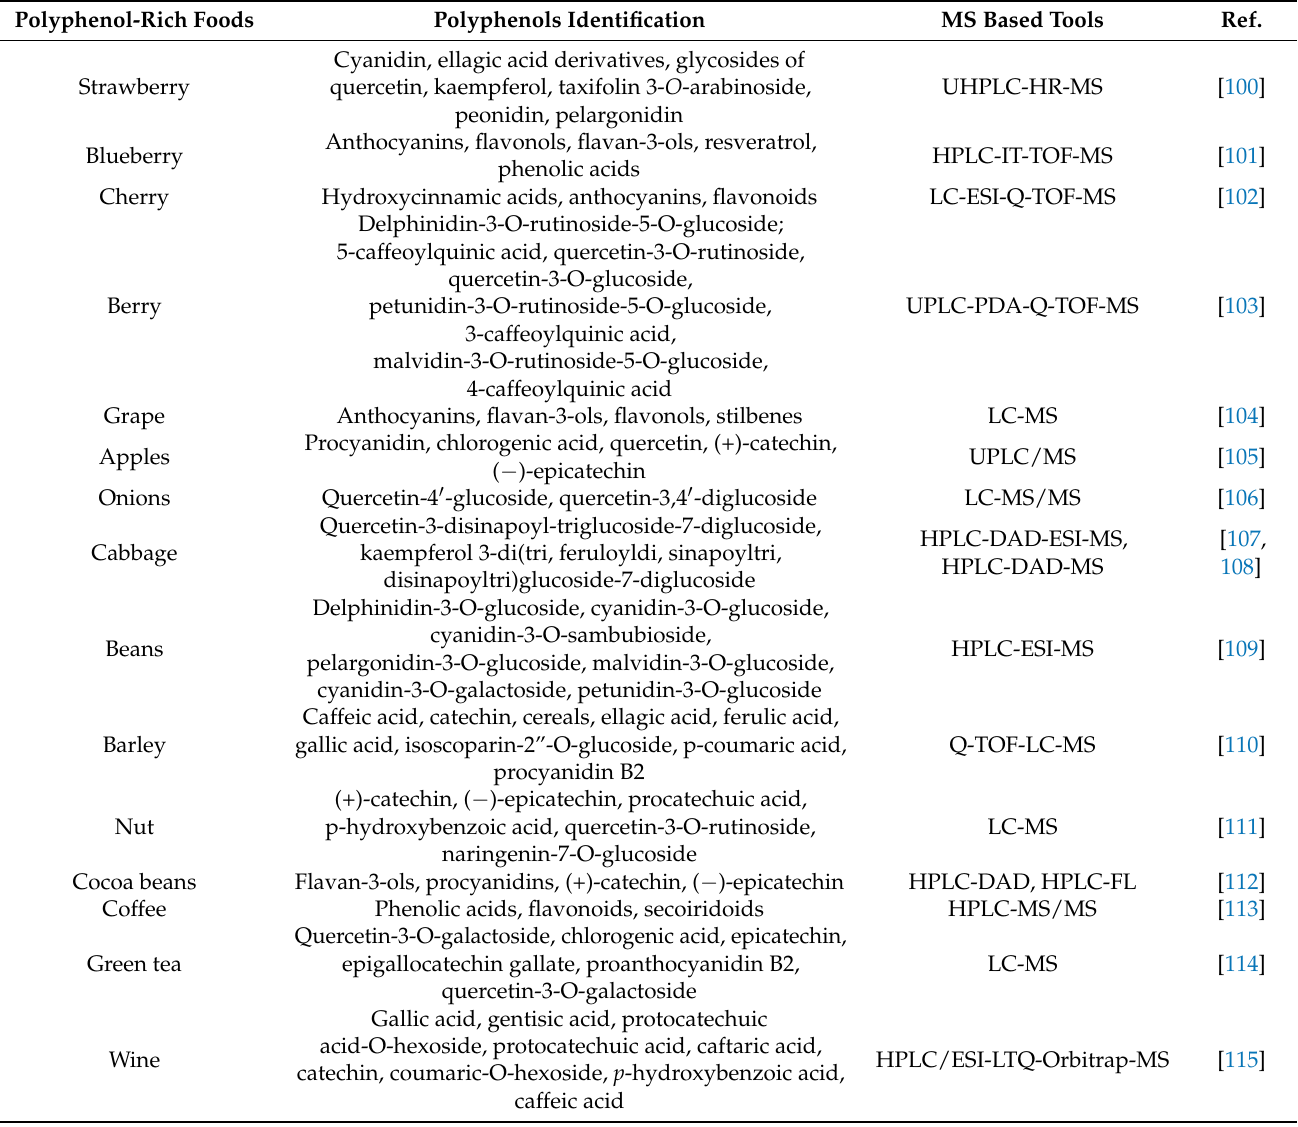
Table 2. Metabolomics used in identifying plant polyphenols of